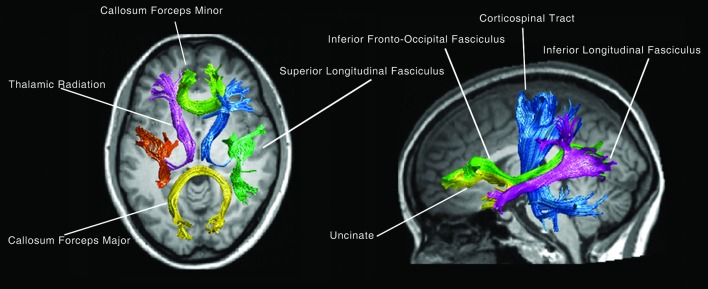
The 14 main fiber bundles.